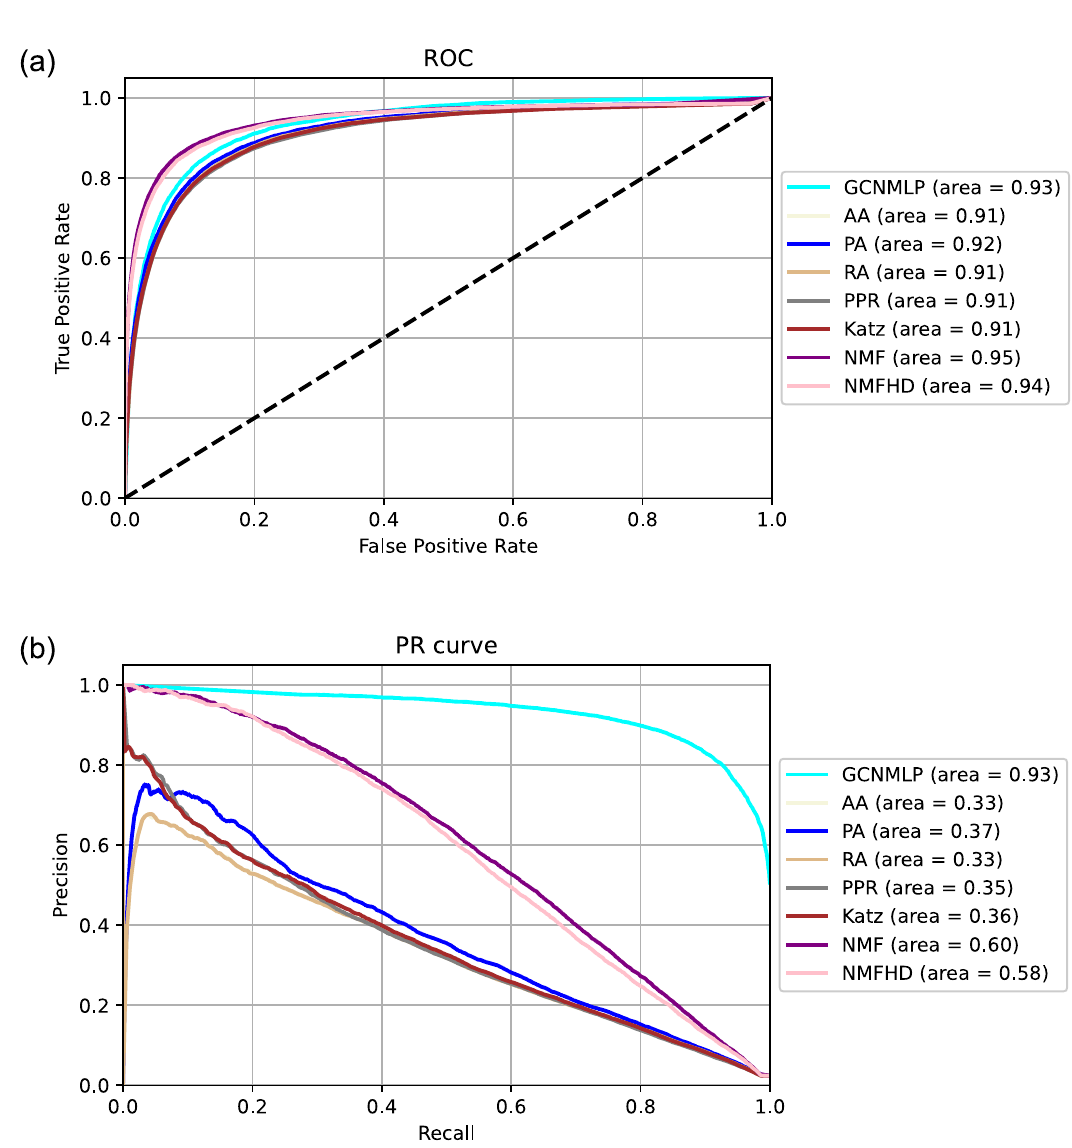
Fig 4. Comparing the performance of various algorithms on the ROC and PR